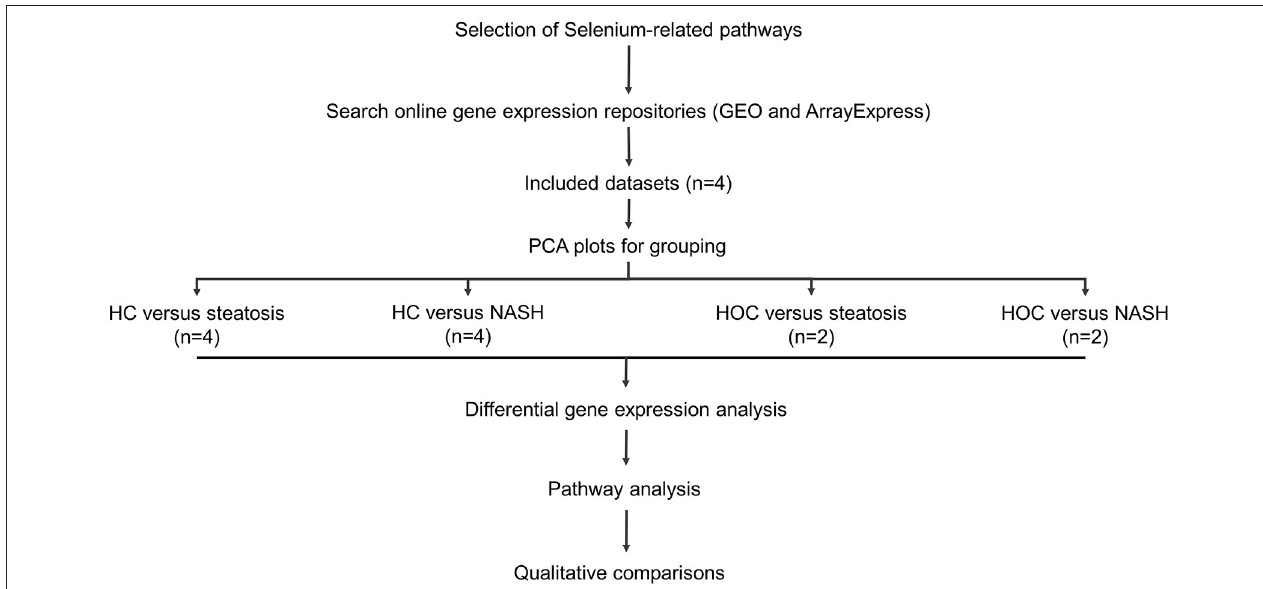
FIGURE 1 | Study workflow. Included datasets were downloaded from GEO or ArrayExpress. PCA plots were used to determine whether normal-weight healthy control (HC) and healthy obese controls (HOC) could be grouped together and whether steatosis and NASH patients could be grouped. All groups were analysed individually. Differentially expressed genes were defined as genes with an adjusted P -value < 0.05. For pathway analysis, genes of interest were defined as genes with a log fold change in the same direction in the majority of datasets (HC: 3/4 datasets, HOC: 2/2 datasets) and where the difference was significant in at least 50% of these datasets. HC, normal-weight healthy controls; HOC, healthy obese controls; NAFLD, non-alcoholic fatty liver disease. n, number of studies used for the